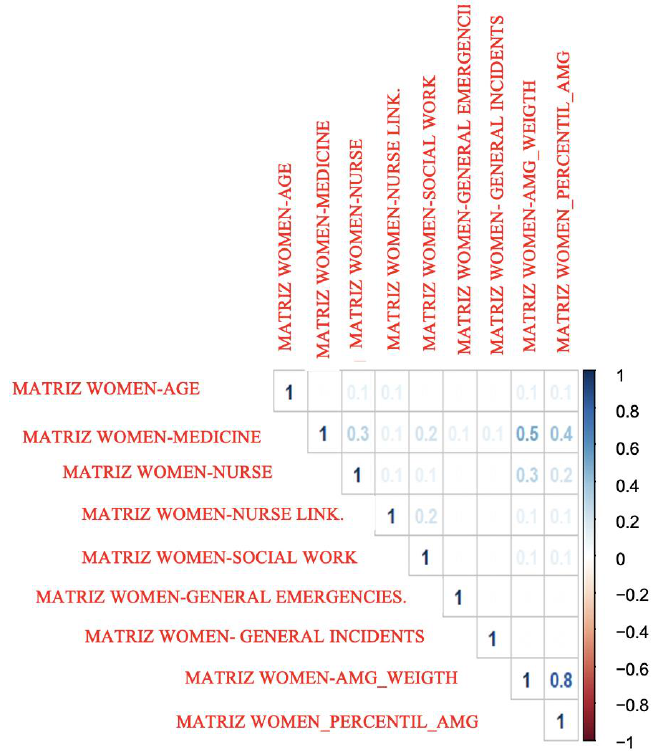
Figure 3. Correlations between all quantitative variables for women. Basic Health Areas of Gran Canaria. 2018–2020. Correlation coefficient.